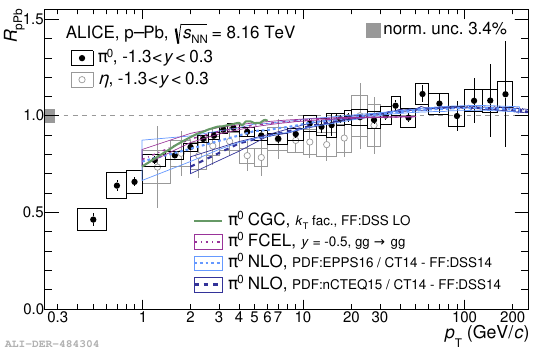
(cid:112) = 8.16 TeV as function of s NN